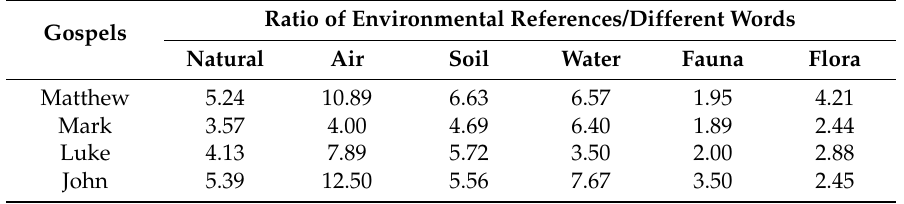
Table 7. Ratio of environmental references/unique words of the natural